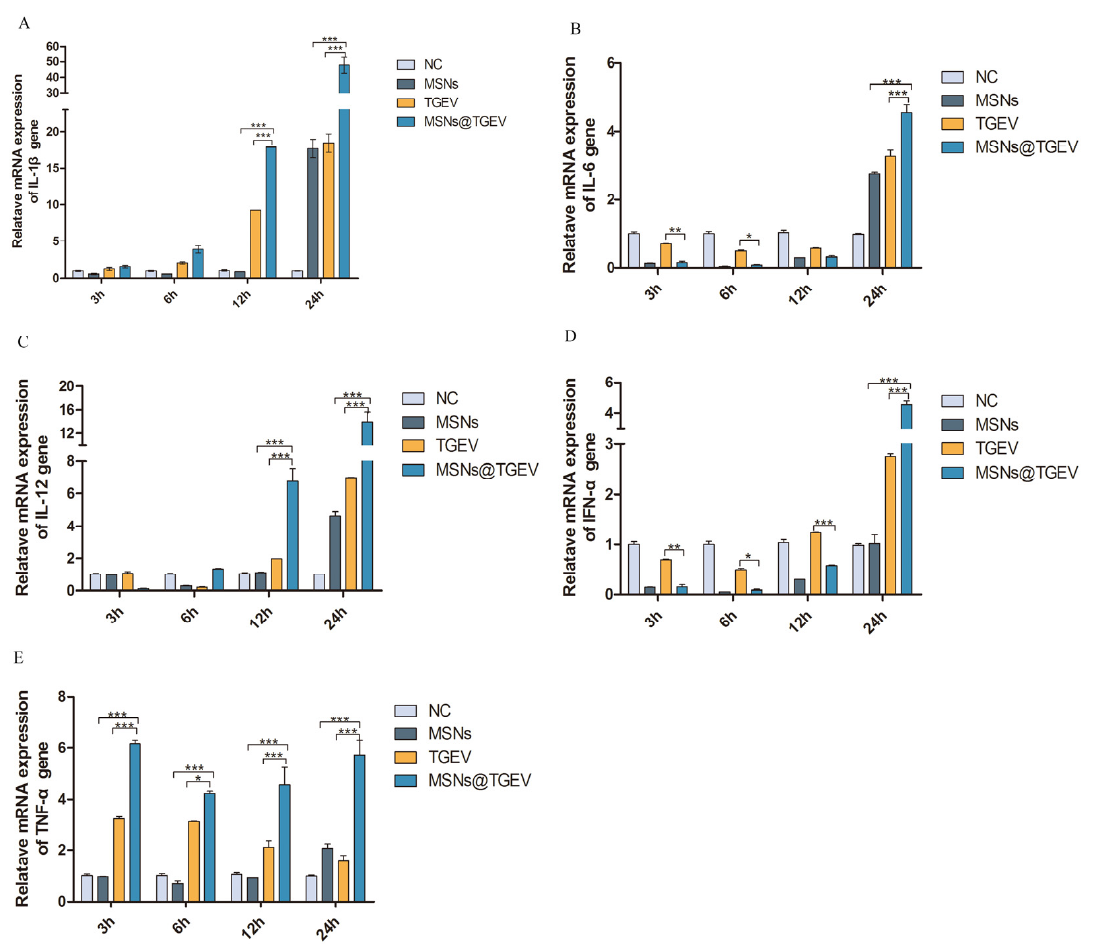
Figure 7. mRNA expression of cytokines on DCs after incubation with inactivated TGEV vac cine with MSNs for different times. Im-DCs were cultured with MSNs, inactivated TGEV and inactivated TGEV vaccine with MSNs, and cells were harvested at 3 h, 6 h, 12 h, and 24 h, respectively. Im-DCs untreated were negative control. mRNA expression of cytokines was assessed by real-time PCR. ( A ) the expressions of IL-1 β ; ( B ) the expressions of IL-6; ( C ) the expressions of IL-12; ( D ) the expressions of IFN- α ; ( E ) the expressions of TNF- α . Data were presented as mean ± SD of three duplicate samples. Differences were considered significant at (*) p < 0.05, (**) p < 0.01, (***) p < 0.001.